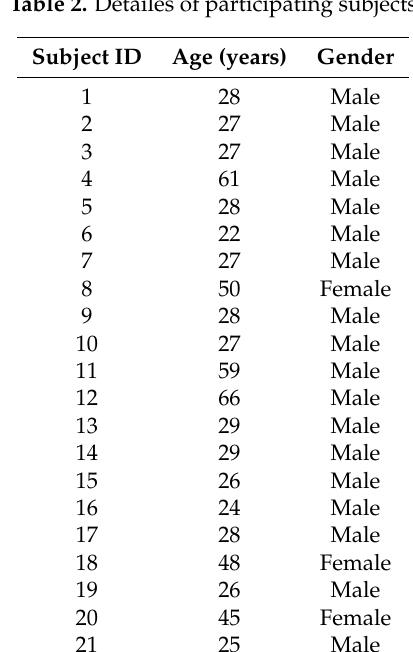
Table 2. Detailes of participating